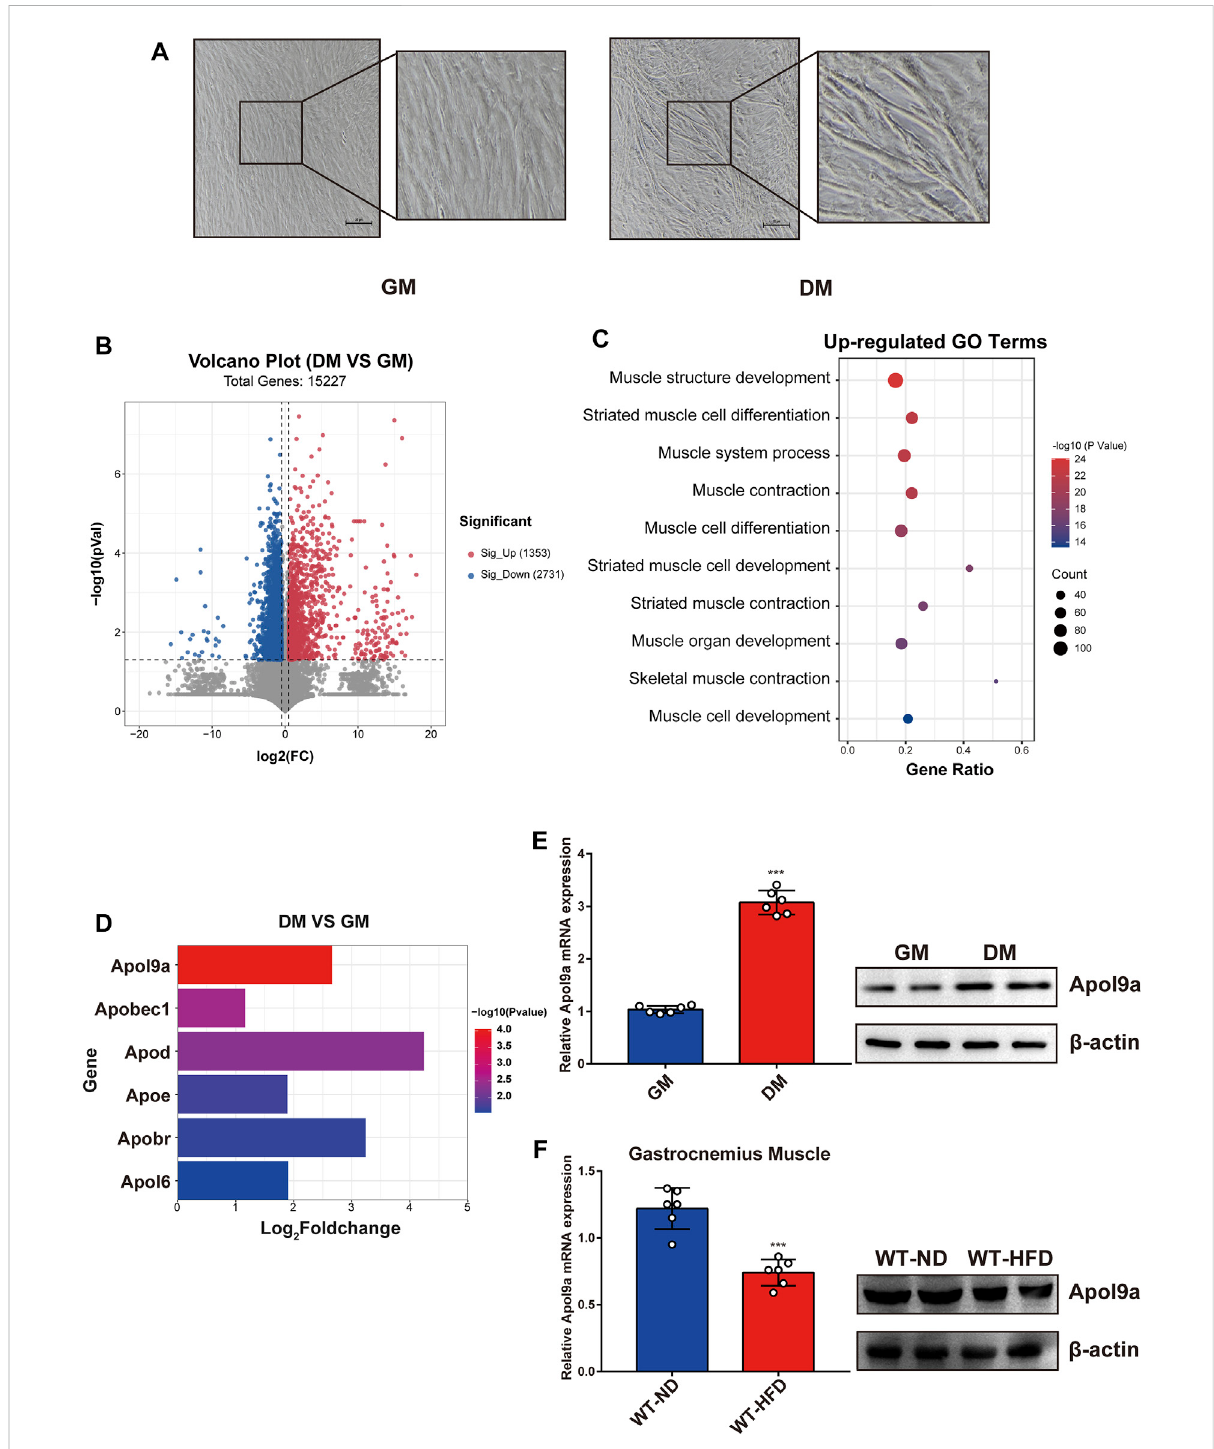
FIGURE 2 Apol9a is increased in myogenic differentiation and decreased in obese mice. RNA sequencing (RNA-seq) data of C2C12 cells with or without myogenicinductionwerecollected. (A) RepresentativeimagesfromC2C12cellsingrowthmedium(GM)anddifferentiationmedium(DM).Scalebar, 100 μ m. (B) Volcano plot showing differentially expressed genes (DEGs) in differentiated or undifferentiated C2C12 cells. (C) Ten most upregulated GO terms during C2C12 differentiation according to the RNA-seq data. (D) Expression pro fi les of apolipoprotein family genes during C2C12 differentiation. (E) The relative mRNA expression (left) and protein levels (right) of Apol9a during C2C12 differentiation were measured using qPCR and western blotting. (F) The relative mRNA expression (left) and protein levels (right) of Apol9a in obese skeletal muscle were measured through qPCR and western blotting. The data are presented as mean ± SEM from at least three separate experiments. * p < 0.05, ** p < 0.01, *** p <